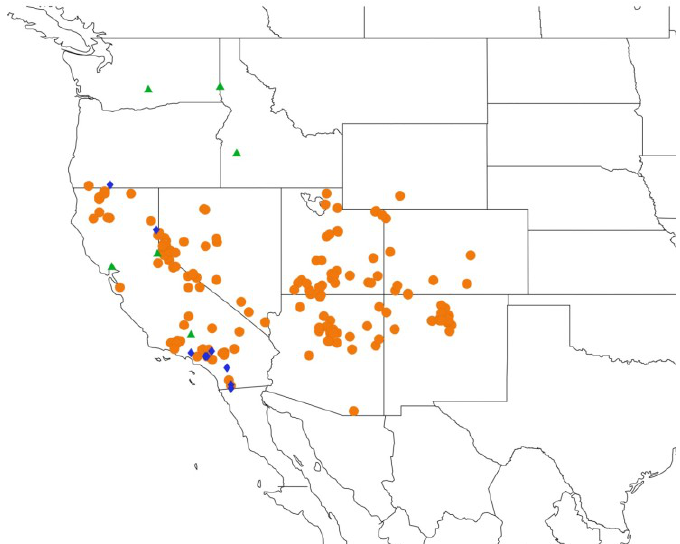
Figure 59. Distribution of Okanagana magnifica (orange circles), O. simulata (blue diamonds) and O. napa (green